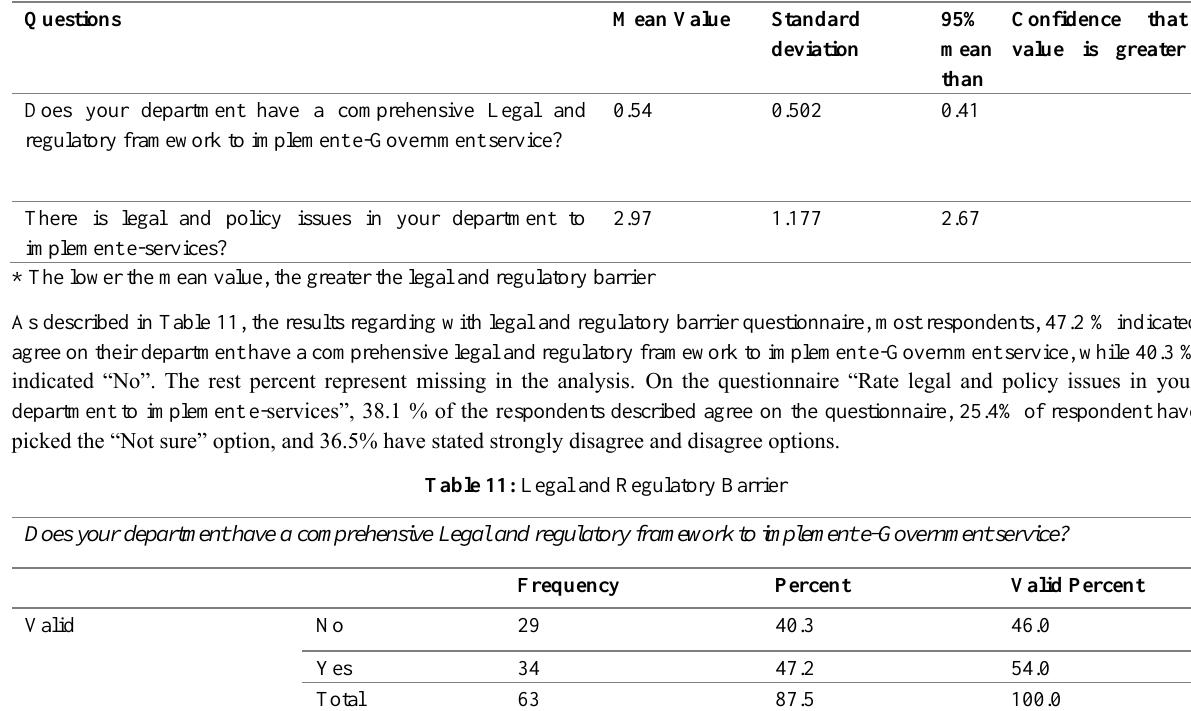
Table 10 : Results of Questionnaire Processing Related to Legal and Regulatory Barrier